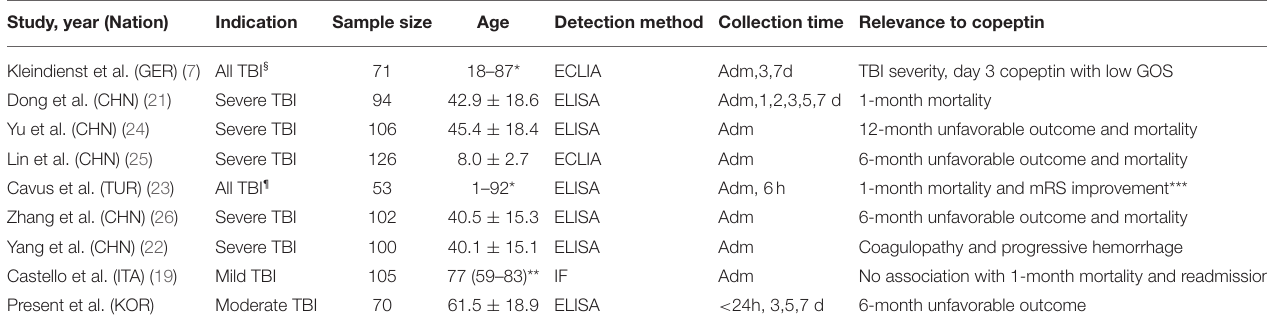
TABLE 3 | Summary of previous studies investigating the association between plasma copeptin and outcomes in patients with TBI. Study, year (Nation) Indication Sample size Age Detection method Collection time Relevance to copeptin Kleindienst et al. (GER) (7) All TBI § 71 18–87* ECLIA Adm,3,7d TBI severity, day 3 copeptin with low GOS 42.9 ± 18.6